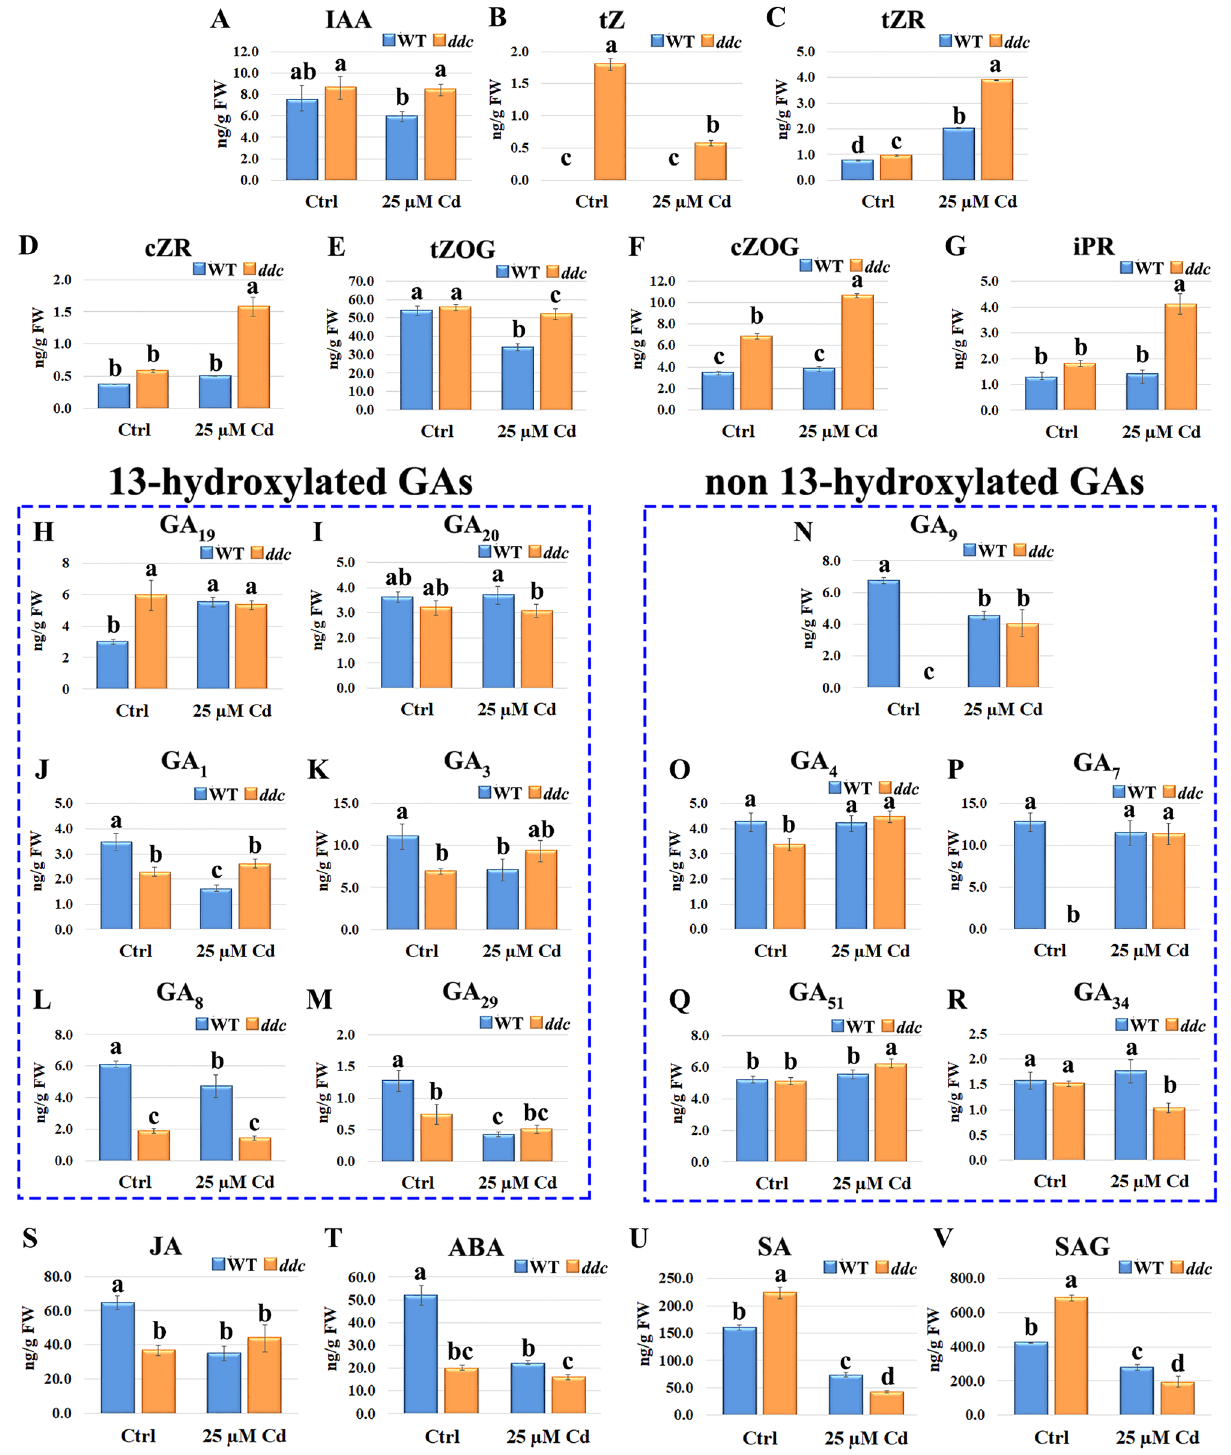
Figure 7. ( A ) IAA, ( B – G ) CKs, ( H – R ) GAs, ( S ) JA, ( T ) ABA, ( U ) SA and ( V ) SAG amount in A. thaliana ddc mutant and WT plants grown in Ctrl conditions and treated with 25 µM Cd estimated by GC–MS. The results represent the mean value (± SD) of three independent biological replicates. Statistical analysis was performed by using two-way ANOVA with Tukey post hoc test ( P ≤ 0.05) after Shapiro–Wilk normality test. Means with the same letter are not significantly different at P ≤